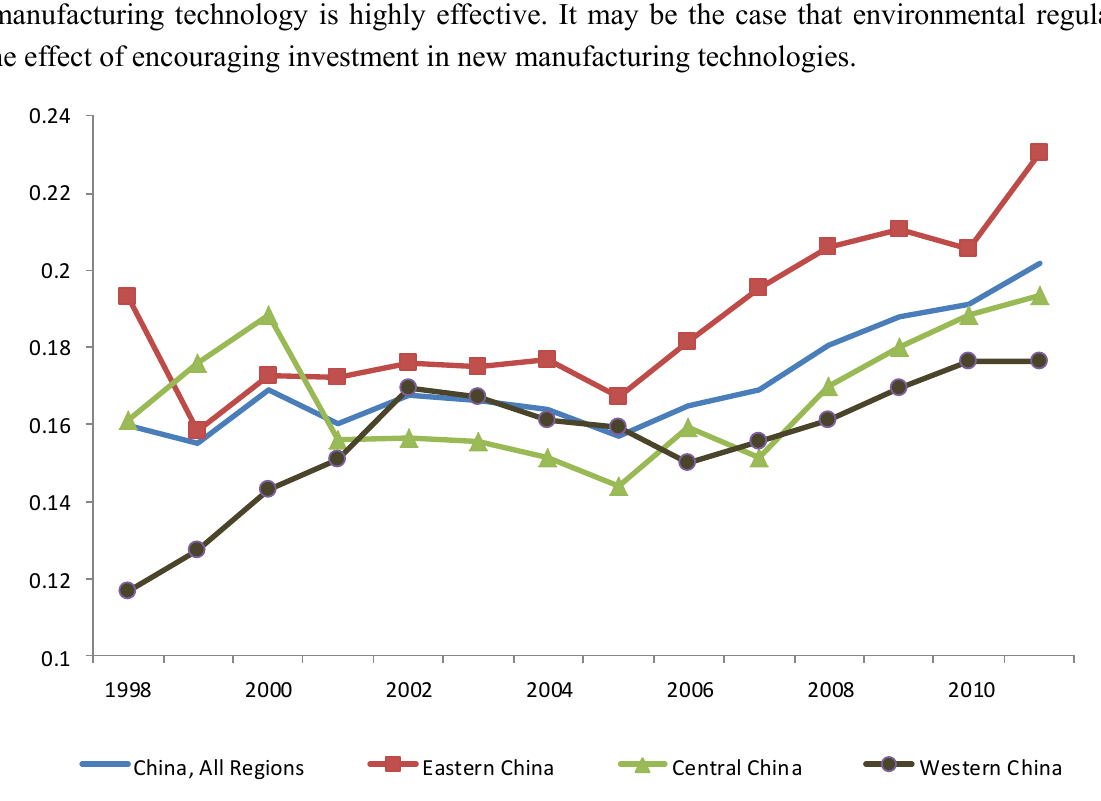
Figure 4. China’s regional shadow price of